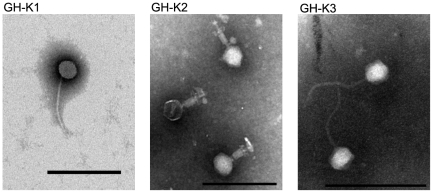
Morphology of phages as revealed by TEM.Three phages displayed different morphology. GH-K2 displayed a short and contractile tail. The tails of GH-K1 and GH-K3 were long, and the tail of GH-K3 appeared more flexible than that of GH-K1. The bars represent 200 nm.